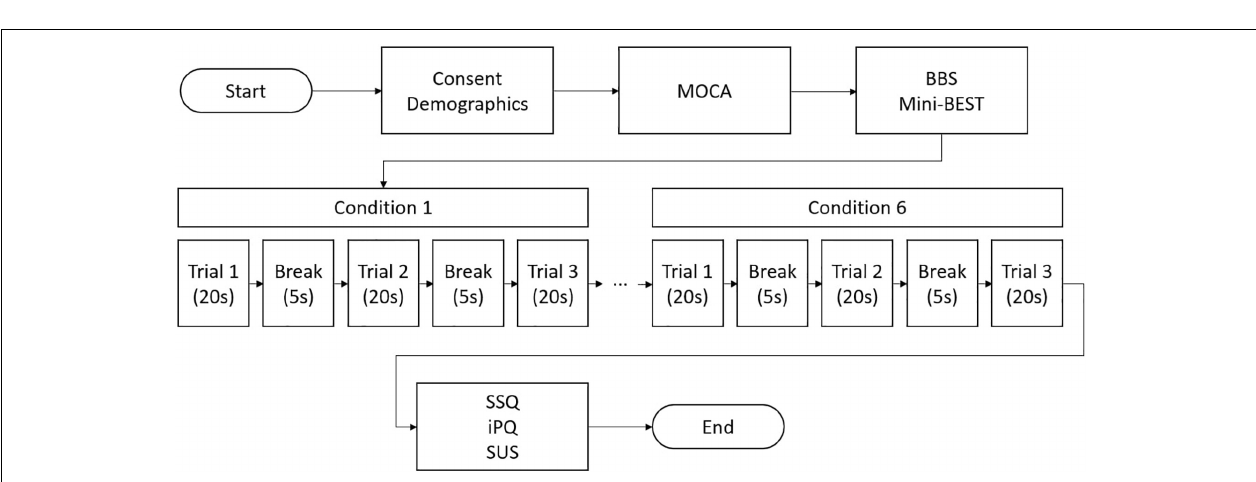
FIGURE 3 | Six VR-ComBAT conditions in the virtual environment. Conditions 1 and 4, conditions 2 and 5, and conditions 3 and 6 share the same VR balance testing environments.